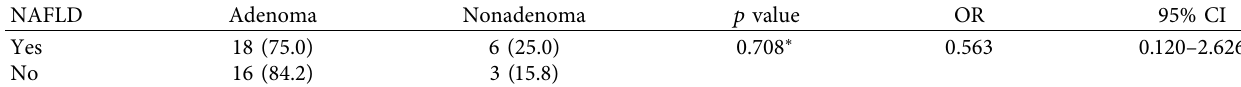
Table 4: Association between NAFLD and polyp type ( n � 43).